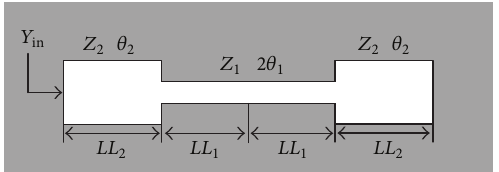
Figure 3: Layout of the proposed stepped-impedance DGS res-